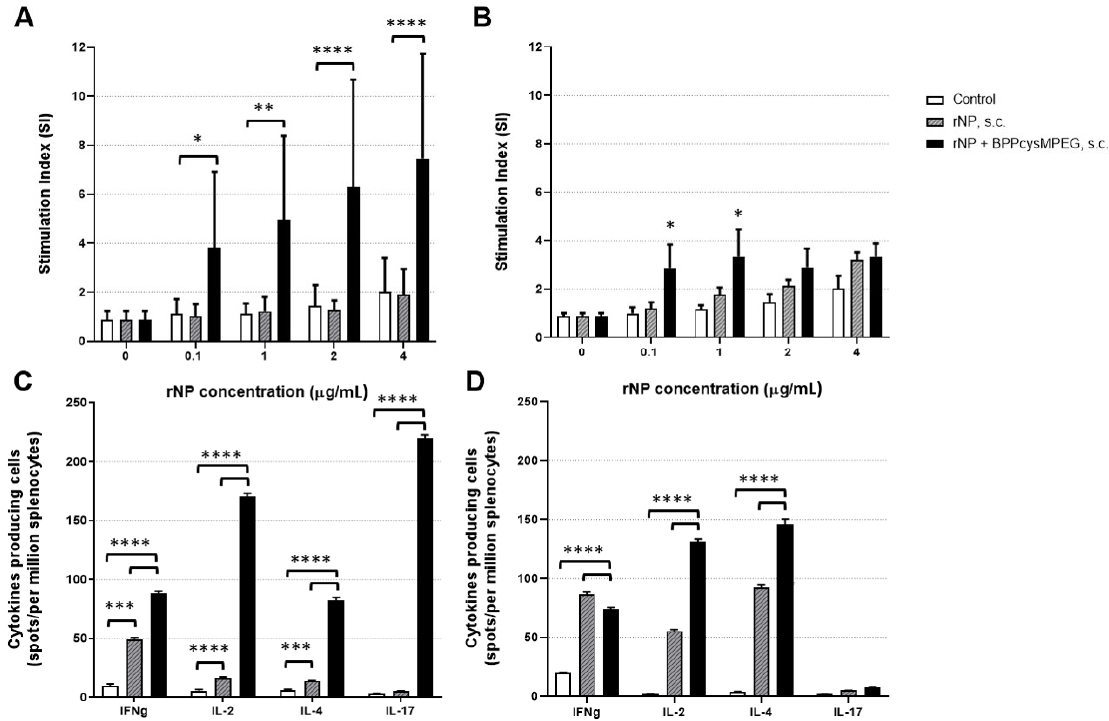
Figure 3. Analysis of the NP ‐ specific cellular responses of mice vaccinated with the formulations by i.n. and s.c. route. Proliferation of splenocytes from mice with PBS (control), rNP and rNP co ‐ administered with BPPcysMPEG, stimulated with increasing concentration of NP measured by the incorporation of the radioactivity of [ 3 H] thymidine. Results are expressed as stimulation index (SI), which is the ratio of [ 3 H] ‐ thymidine uptake of stimulated versus unstimulated samples ( A , B ). Number of IFN ‐γ , IL ‐ 2, IL ‐ 4, and IL ‐ 17 ‐ producing cells were evaluated in splenocytes by ELISPOT. Results are expressed as the number of spots of cytokine ‐ producing cells per 10 6 spleen cells after subtraction of background values of unstimulated cells ( C , D ). Statistical analysis between the adjuvanted and non ‐ adjuvanted groups was performed by two ‐ tailed Student’s t ‐ test. Differences were statistically significant (* p < 0.1), (** p < 0.01), (*** p < 0.001) and (**** p < 0.0001) with respect to values obtained in control mice and/or mice receiving rNP